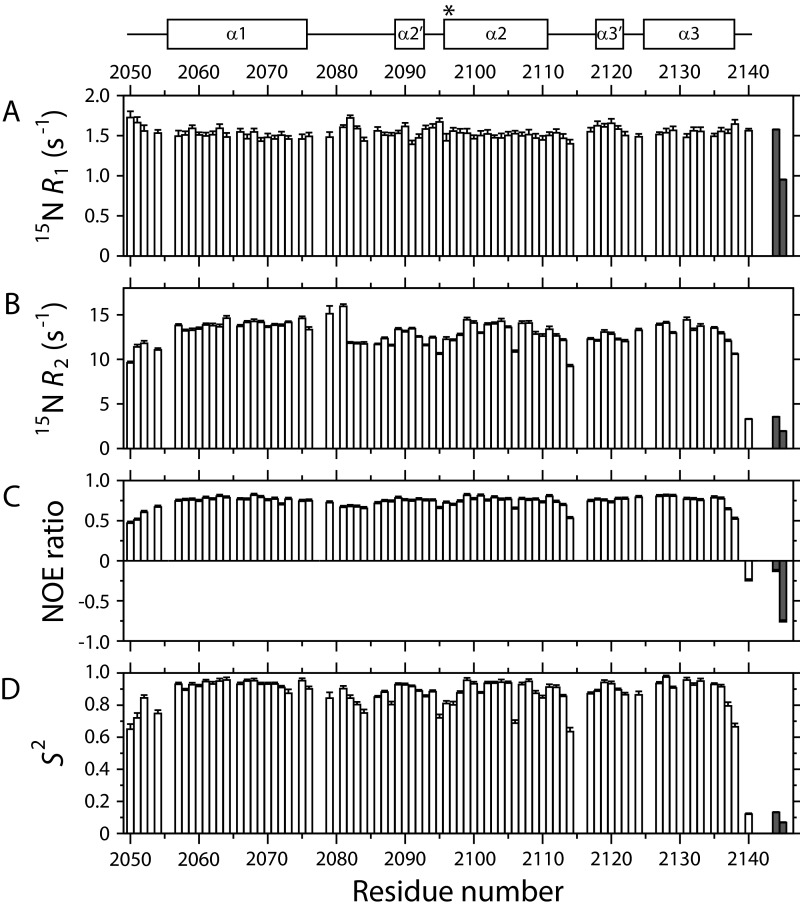
15N relaxation parameters for holo mACP9Underneath a schematic defining the boundaries of α-helices in the structure of apo mACP9, NMR parameters for backbone and prosthetic group amide sites in the holo state are plotted as a function of residue number for: (A) the 15N longitudinal relaxation rate, R1; (B) the 15N transverse relaxation rate, R2; (C) the {1H}-15N NOE ratio (I′/I0, where I′ is the intensity when the 1H spectrum has been saturated and I0 is the intensity in the reference spectrum); and (D) the Lipari–Szabo the order parameter, S2. Bars shaded in grey correspond to values for the N8 (left) and N4 (right) sites of the prosthetic group.